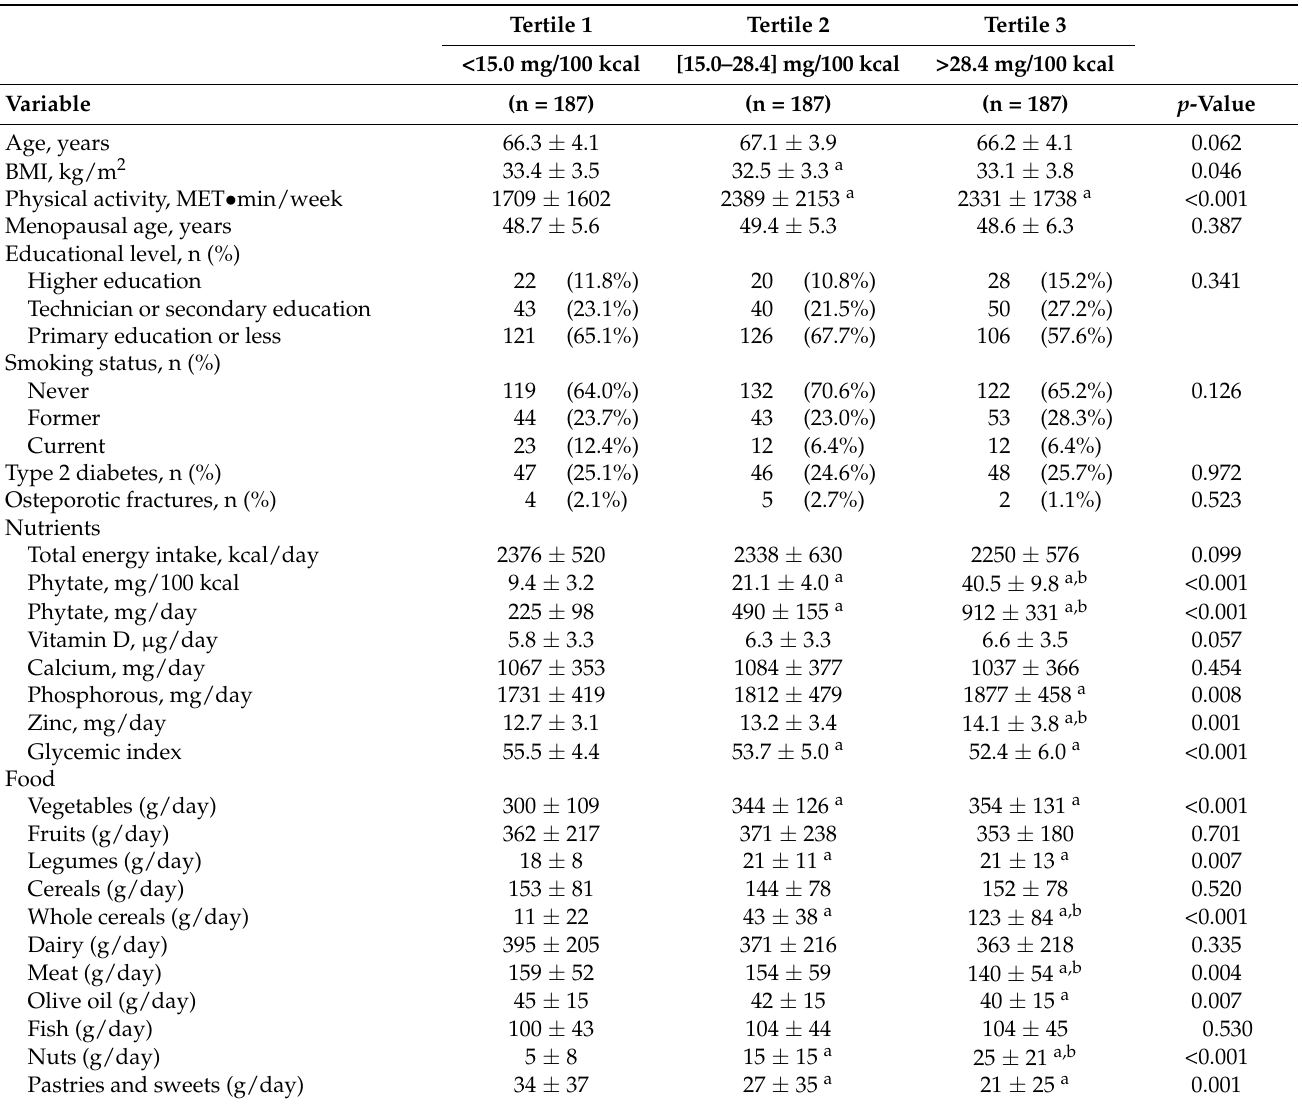
Table 2. Anthropometric, lifestyle and dietary characteristics of study participants according to tertiles of estimated phytate intake (mg/100 kcal ·